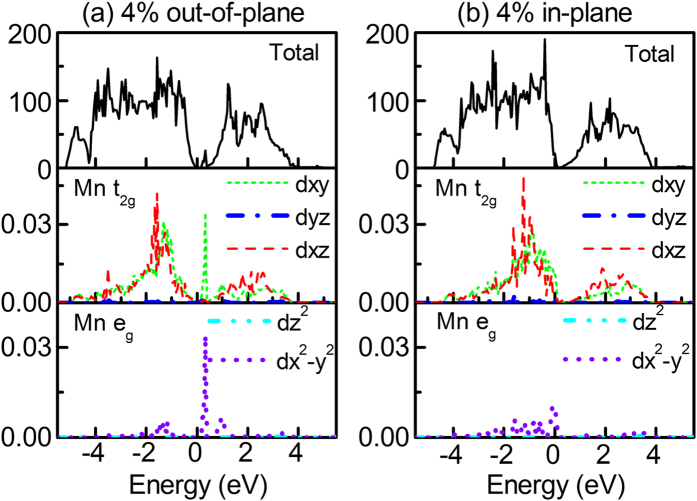
Total and partial densities of states of Mn doped Bi2Se3.(a) with 4% out-of-plane. (b) 4% in-plane strains.